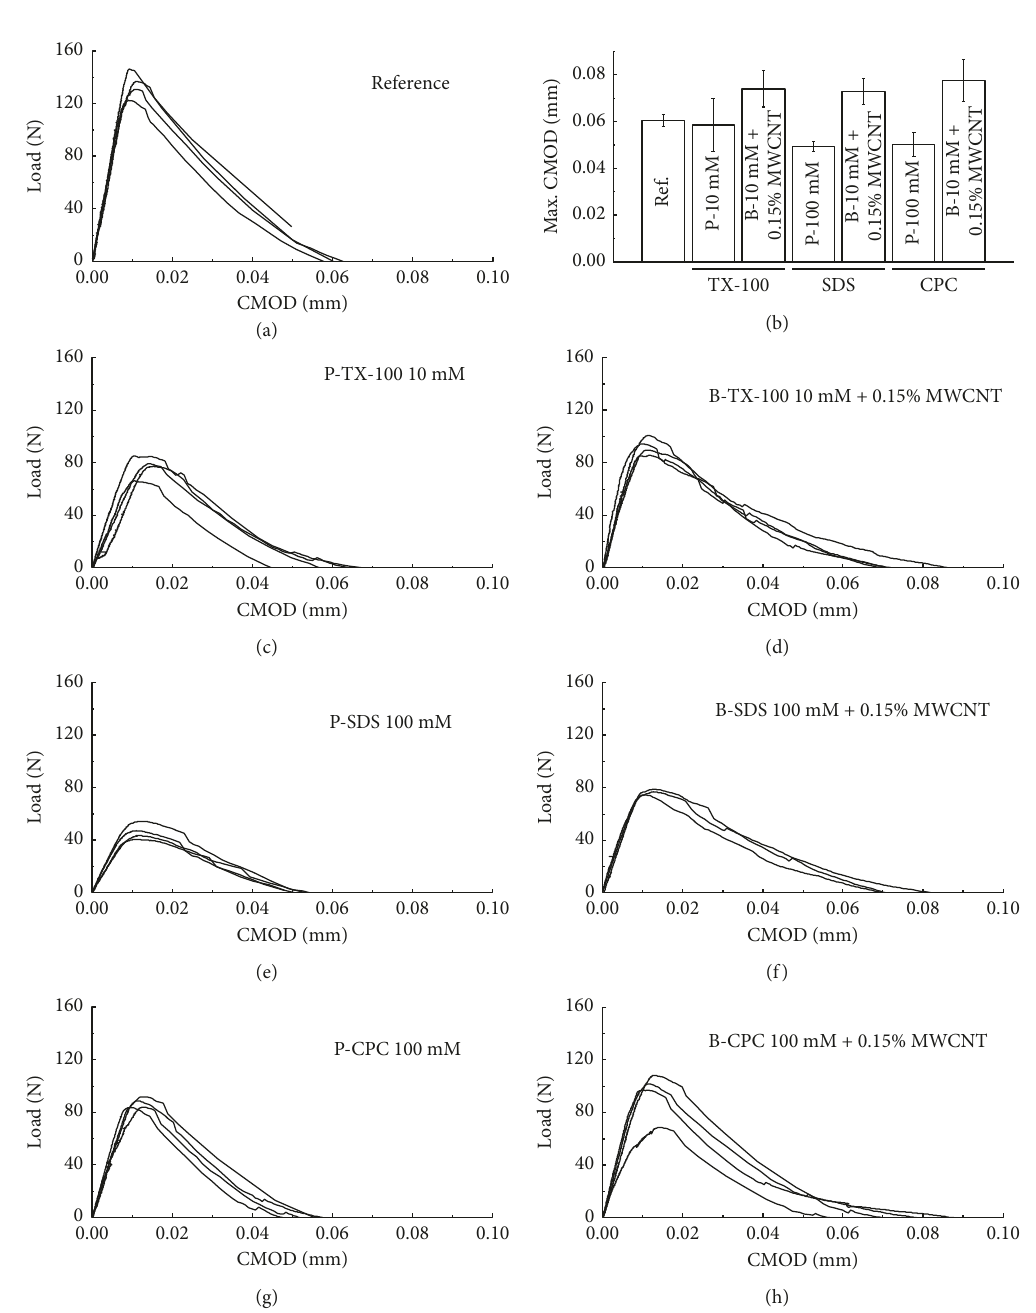
Figure 12: Load versus CMOD for all pastes tested in three-point